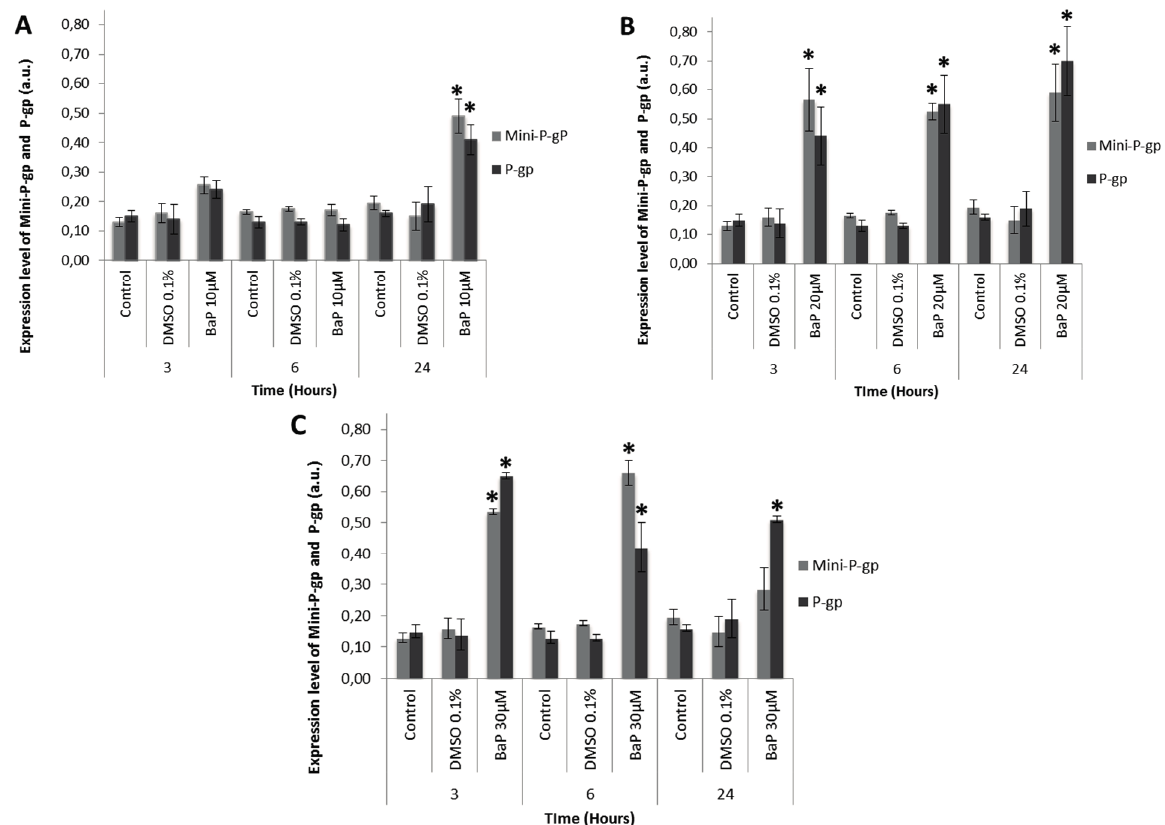
Figure 3. Mini-P-gp and P-gp co-expression in primary cultures of trout erythrocytes in the presence of increasing B a P concentrations. Experiments were performed by Western blot analysis. MDR expression level was quantified using Quantity One software (Biorad ® , publisher, Marnes-la-Coquette, France). a.u.: Arbitrary Units. Red blood cells were treated for 3 h, 6 h and 24 h with ( A ): 10 μ M B a P; ( B ): 20 μ M B a P; and ( C ): 30 μ M B a P. * indicates a significant difference ( p < 0.05) in mini-P-gp expression and P-gp expression in erythrocyte cultures treated by B a P than